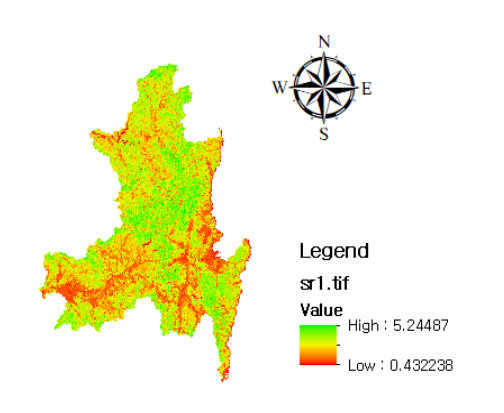
Table 2. Vegetation Index(Rouse et al. 1974, Huete.